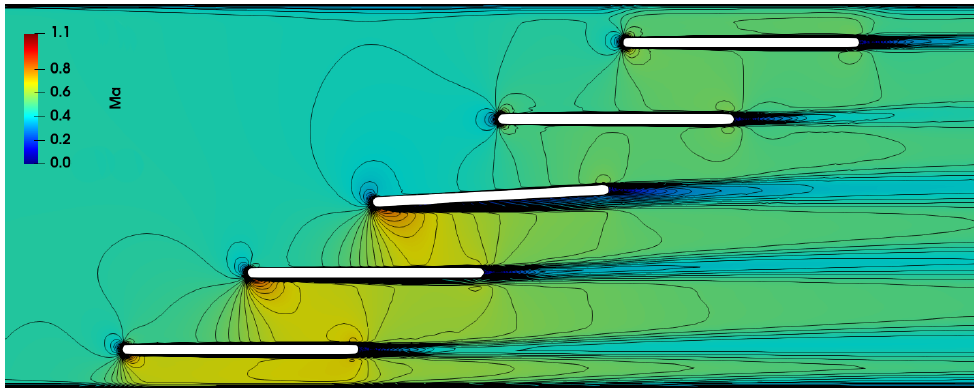
Figure 10. Distribution of the Mach number in the domain, M 2 is = 0.5, α = − 3°.